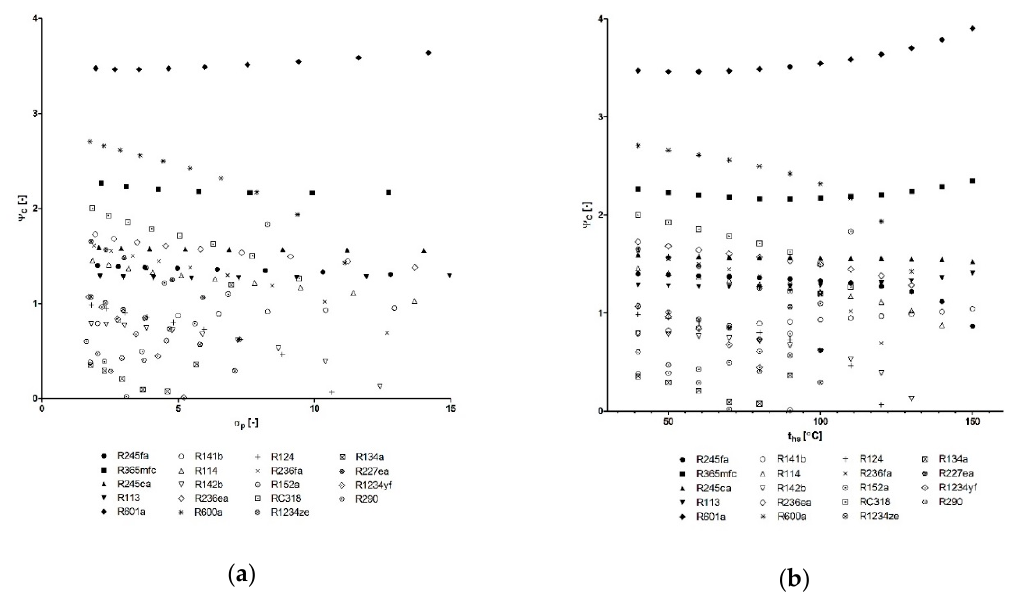
Figure 19. The variation of the ψ C parameter vs. the pressure expansion ratio and heat source temperature: ( a ) ψ C = f( σ P ); ( b ) ψ C = f(t hs ). temperature: ( a )